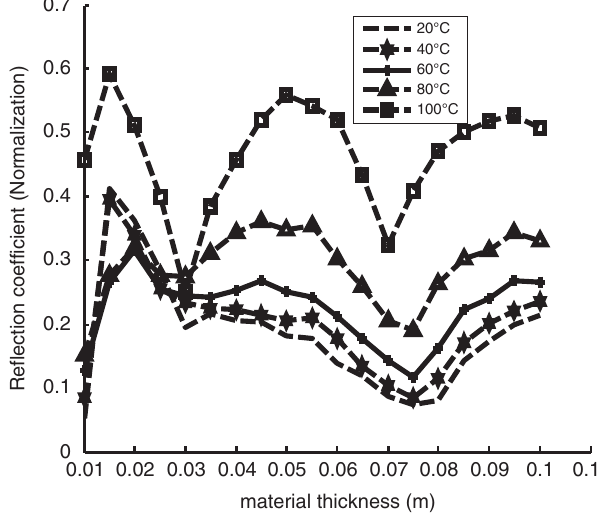
Figure 6: Temperature dependence of reflection coefficient of tita- nium concentrate as the thickness varies from 0.01m to 0.1m: 20° C , 40° C , 60° C , 80° C , 100° C